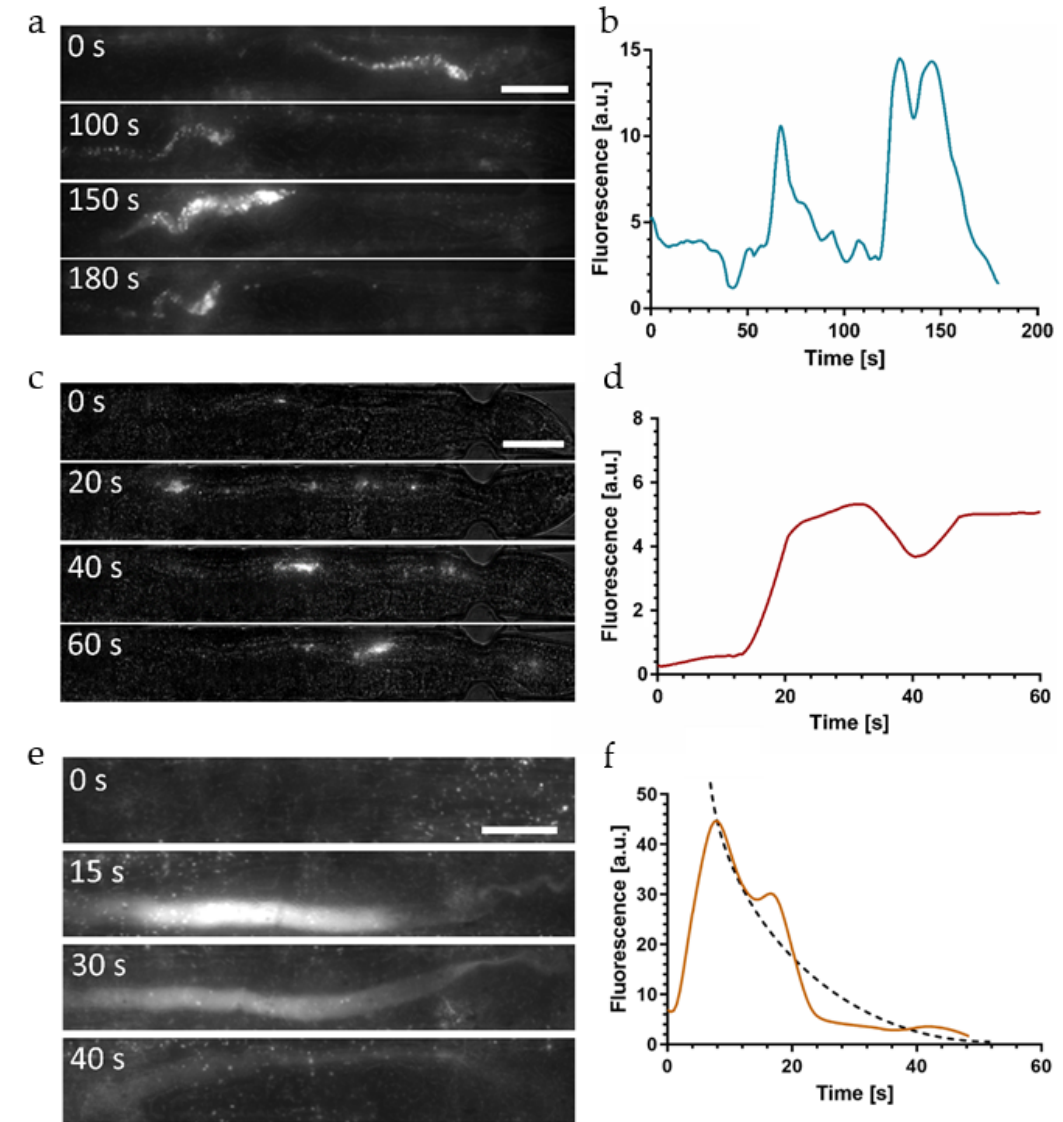
Figure 6. Analysis of transit patterns and bacterial nutrient absorption in the intestine of N2 C. elegans worms by high- resolution brightfield/fluorescence imaging (50 × ). Images and corresponding graphs are shown for a single representative worm for each condition. ( a ) Time-lapse images of the hindgut region of an immobilized YA worm fed a mixture of E. coli OP50 RFP and red fluorescent microbeads. A mixture of fluorescent microbeads and bacteria, residues of a previous ingestion, is visible at t = 0 s. Strong fluorescence observed at t = 150 s was caused by a subsequent peristaltic contraction, pushing intestinal load from the pharynx to the hindgut. ( b ) Average fluorescent signal in the hindgut region corresponding to ( a ). Peaks at t = 70 s and t = 130 s are caused by transient microbead/intact bacteria clusters (initially located in the proximity of the rectal region, at t = 0 s in this image sequence), which were repeatedly pushed back to the pharynx by peristaltic activity. ( c ) Images of the hindgut of a YA worm fed indigestible microbeads only, showing transfer of the beads to the posterior gut region shortly after ingestion. ( d ) Average fluorescence signal of the hindgut region corresponding to ( c ). The intensity remained stable over this short initial time period (60 s) after indigestion, since further peristaltic events did not yet occur. ( e ) Time-lapse images of the hindgut region of an immobilized YA worm fed E. coli OP50 RFP only. An aliquot of disrupted bacteria appearing in the posterior gut section generates strong diffuse fluorescence ( t = 15 s). A gradual decay of fluorescence over time was observed ( t = 30 s and 40 s), associated to biochemical digestion of membrane fragments and nutritive compounds. ( f ) Fluorescent signal corresponding to ( e ) recorded in the hindgut region. Based on additional data (Figure S7, n = 5), an exponential decay curve (dashed line) was defined in order to determine the time constant for food digestion ( 𝜏 = 14 ± 4 s). Scale bars = 50 μ m.